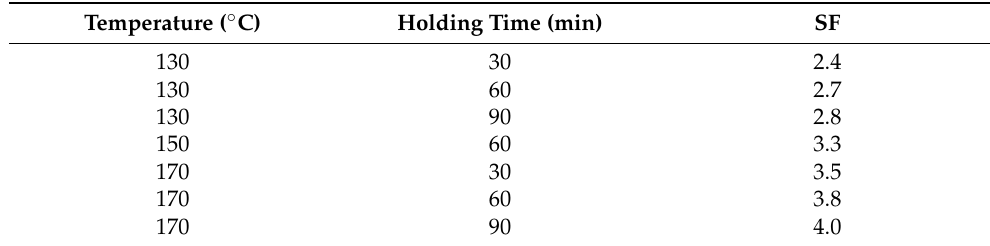
Table 2. Severity factors (SFs) that were reached with different treatment temperatures and holding times during the hydrothermal treatment experiments as shown in Table 1.